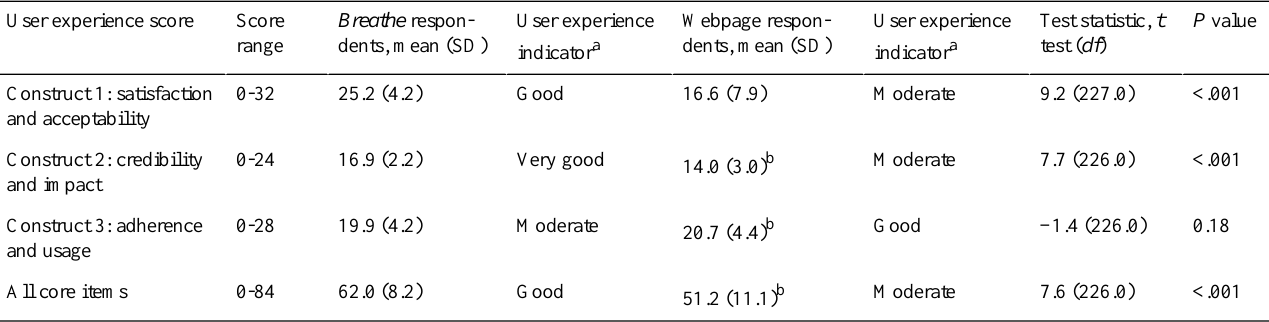
Table 7. The differences between Breathe (n=81) and webpage (n=148) respondents in the construct and core item total scores of the User Experience Questionnaire for Internet-based Interventions.